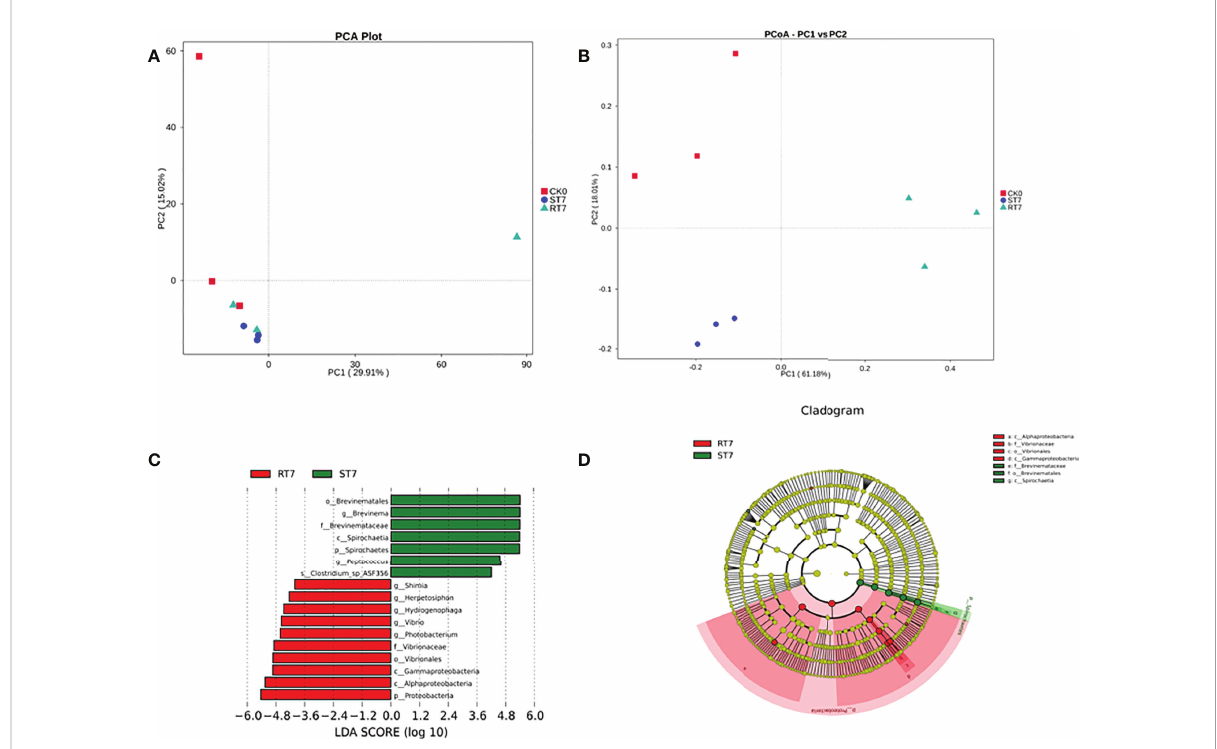
FIGURE 3 Inter-group variation and principal coordinates analysis (PCoA) in the relative abundance of intestine microbial communities. (A) PCoA plots based on weighted UniFrac metrics. (B) PCA plots based on unweighted UniFrac metric. (C) LDA score of Lefse-PICRUSt. The length of the column represents the effect size of bacterial lineages. (D) Lefse cladogram. The bacterial groups from family to class level are listed from center to outside. Each circle ’ s diameter is proportional to the bacterial taxa ’ s abundance. Only the taxa that linear discriminate analysis (LDA) value above 2.5 are shown.